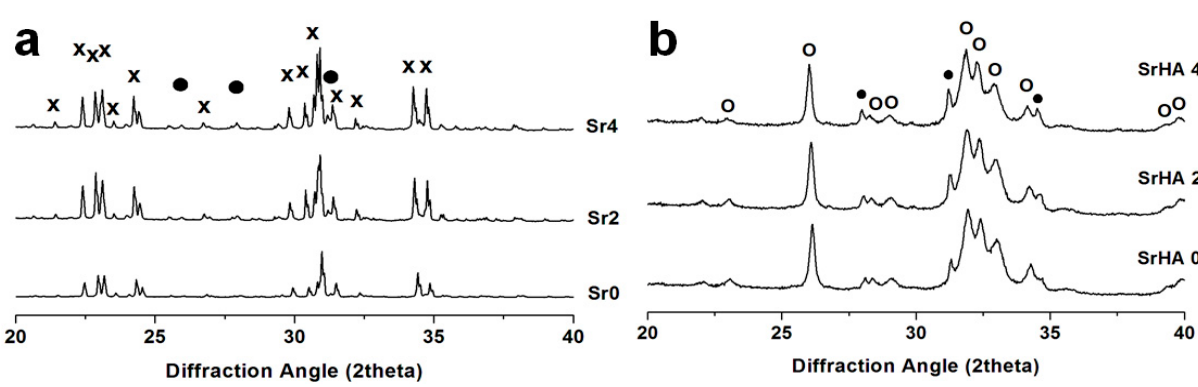
Figure 3. Microstructures of different cement formulations with dwell time of high-temperature powder synthesis equal to 15 min: ( a ) Sr0, 1200 °C; ( b ) Sr4, 1200 °C; ( c ) Sr0, 1600 °C; ( d ) Sr4, 1600 °C after 24 h at 37 °C. Scale bar: Image = 20 µm, insets = 5 µm.